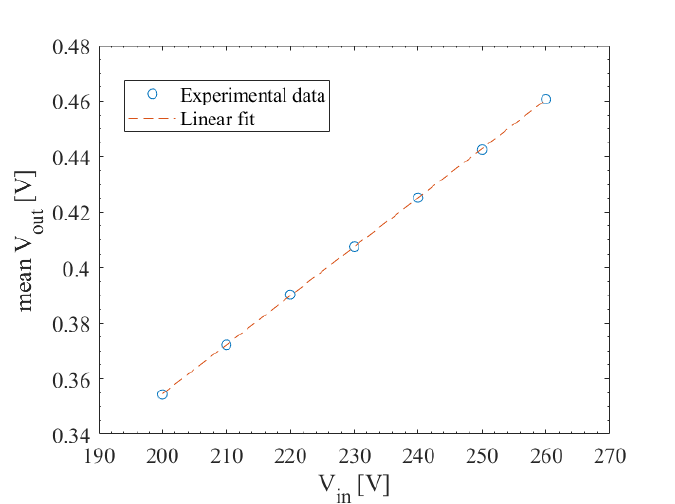
Figure 4. Estimated characteristic of the adopted voltage sensor.